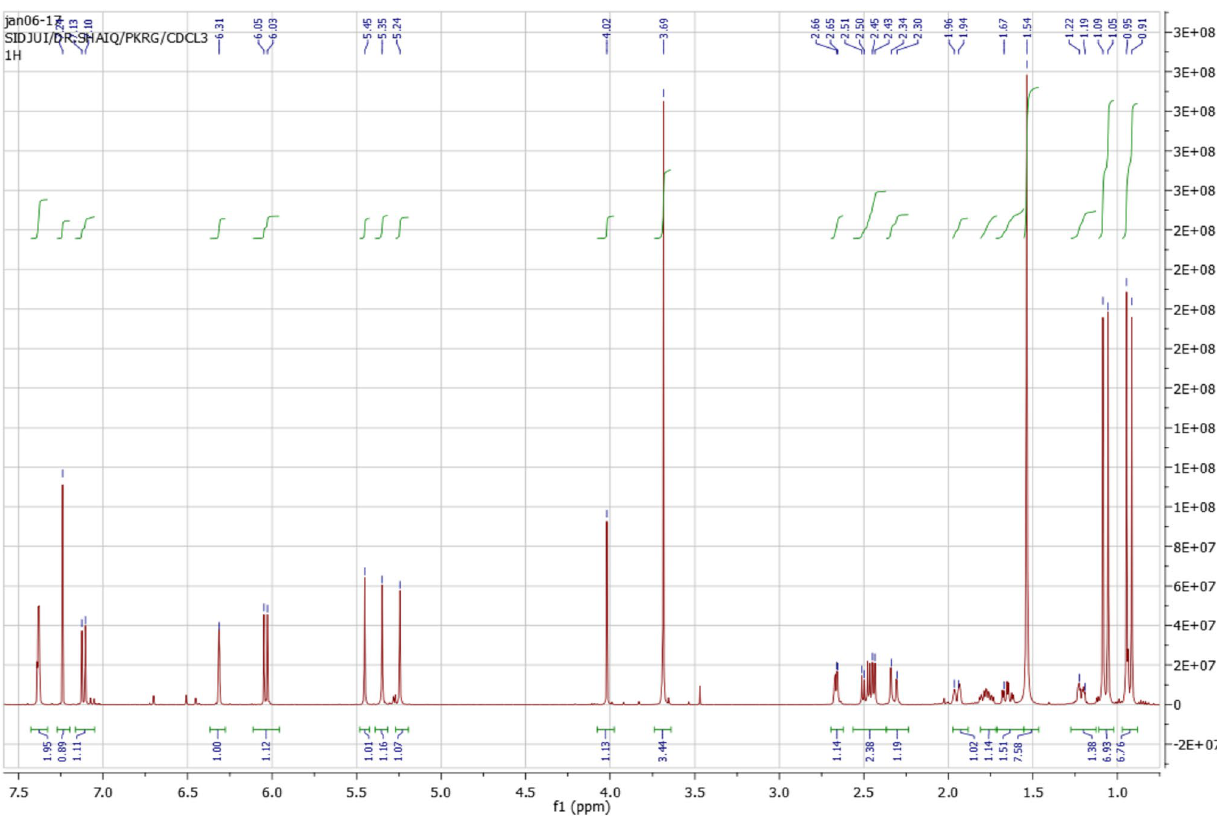
Fig. 7 Experimental data 1 H NMR spectrum of andirobin (CDCl